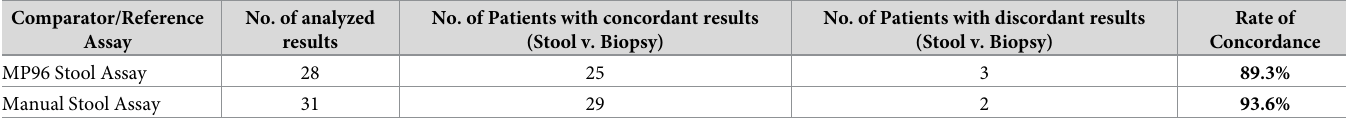
Table 2. Matching patient genotype predictions from MP96 biopsy assay compared to MP96 stool assay and the reference manual stool assay. Comparator/Reference